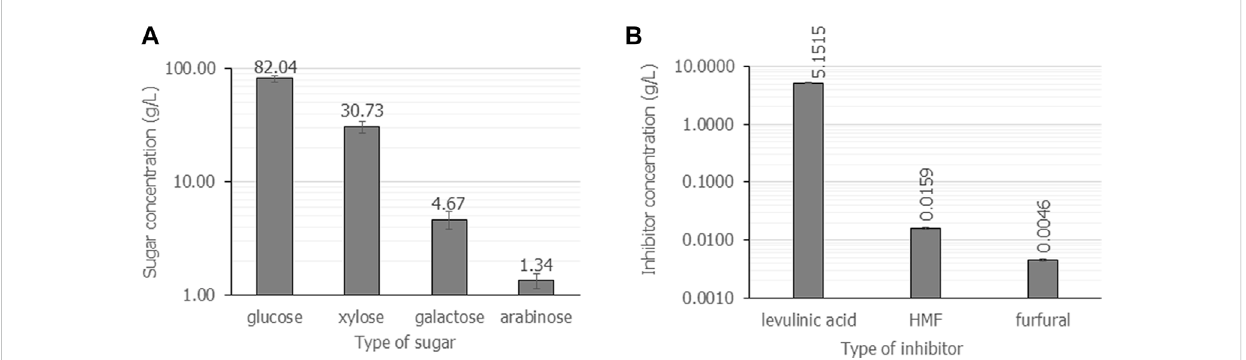
FIGURE 1 The composition of fermentable sugars (A) and inhibitors (B) when cassava pulp was hydrolyzed with liquid-to-solid ratios of 20 mL/g using 2.5% (v/v) H 2 SO 4 under microwave irradiation at 800 W for 8 min. All the data are representative of the results of three independent experiments and are expressed as the mean values ± standard deviations